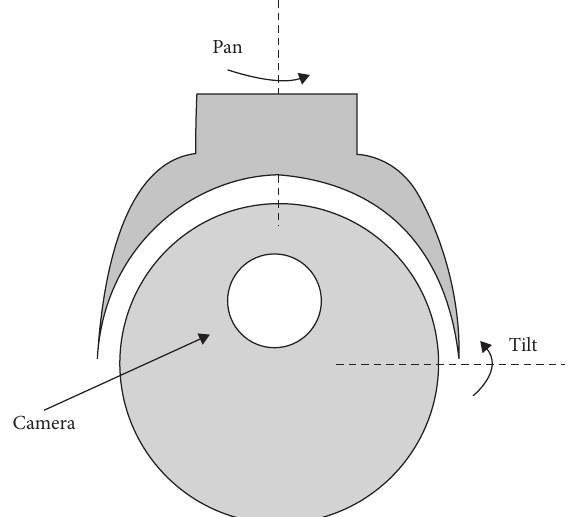
Figure 1: Front view of the yaw-pitch gimbal; a camera is mounted on the top of the inner